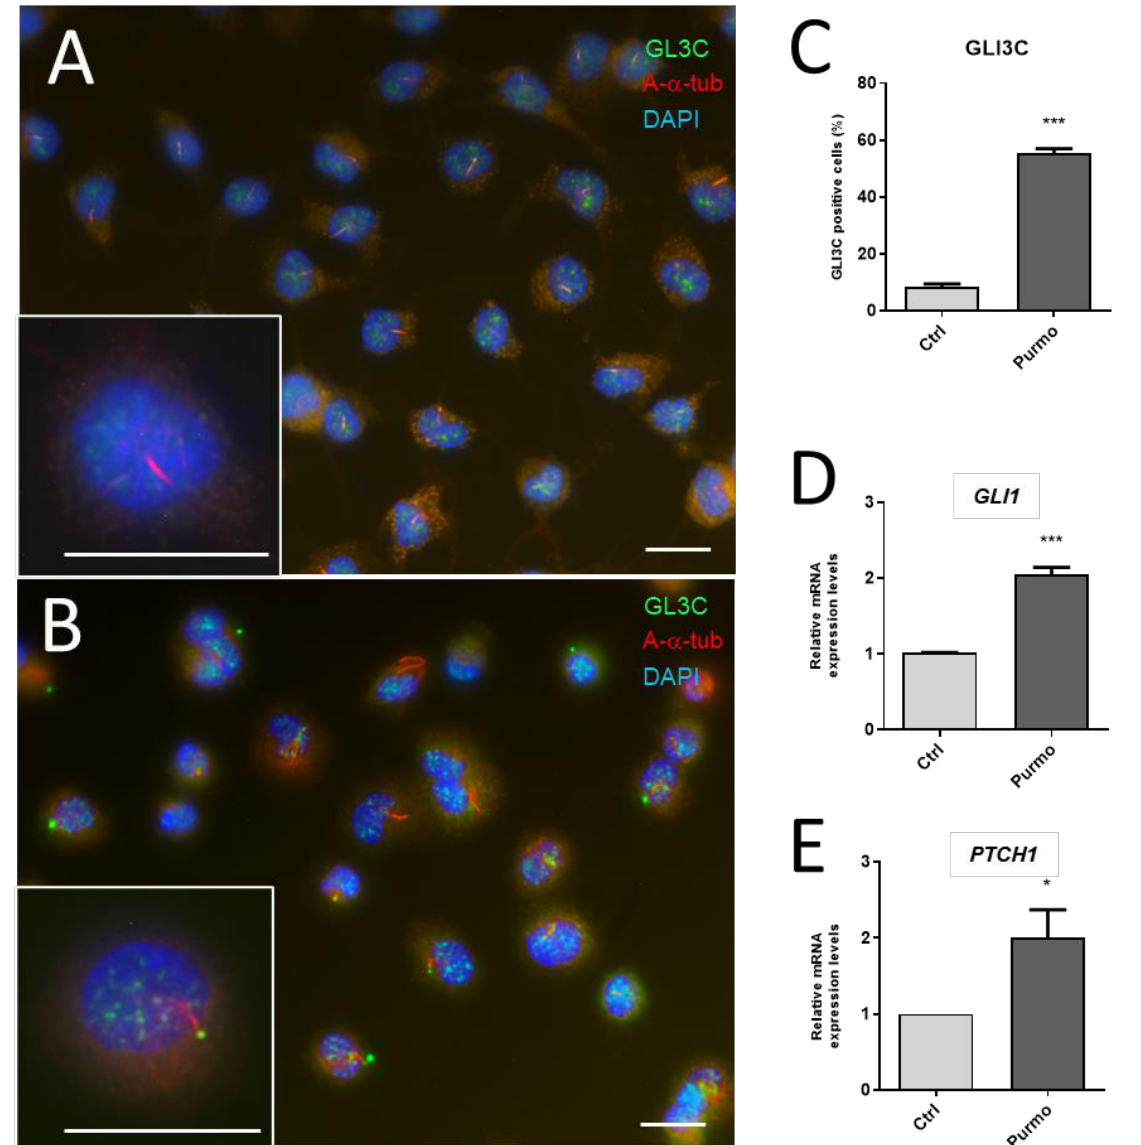
Figure 13. Stimulation of the HH pathway in response to purmorphamine in HIEC cells. Quiescent post-confluent HIEC cells were untreated ( A ) or treated with 2 µ M purmorphamine (Purmo) ( B ) for 24 h and analyzed for the HH activity marker GLI3C ( A – C ) and expression of downstream target genes GLI1 ( D ) and PTCH1 ( E ). Primary cilia were detected using an anti-acetylated- α -tubulin (A- α -tub; red staining) in most post-confluent HIEC cells ( A , B ). Accumulation of GLI3C expression at the tip of primary cilia with an anti-GLI3C (green staining) was found in ~10% of control cells ( A , C , Ctrl) while it was detected in more than 50% of the Purmo-treated cells ( B , C , Purmo). Bars in ( A , B ) are equal to 10 µ m. ( D , E ): Expression of GLI1 and PTC1 transcripts was also significantly increased in Purmo-treated cells. *, p < 0.05; ***, p <